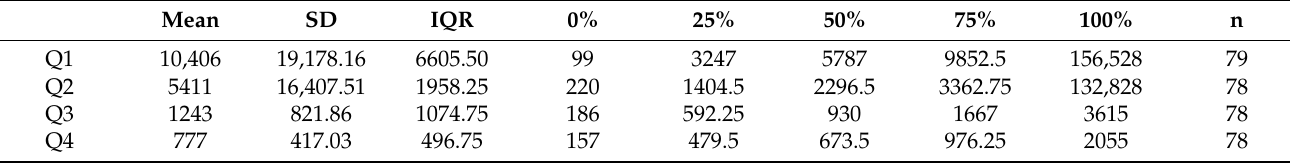
Table 4. Women (inhabitants). Sources: own elaboration based on data from the Galician Institute of Statistics (IGE), Municipal Register of Inhabitants, the year 2021.